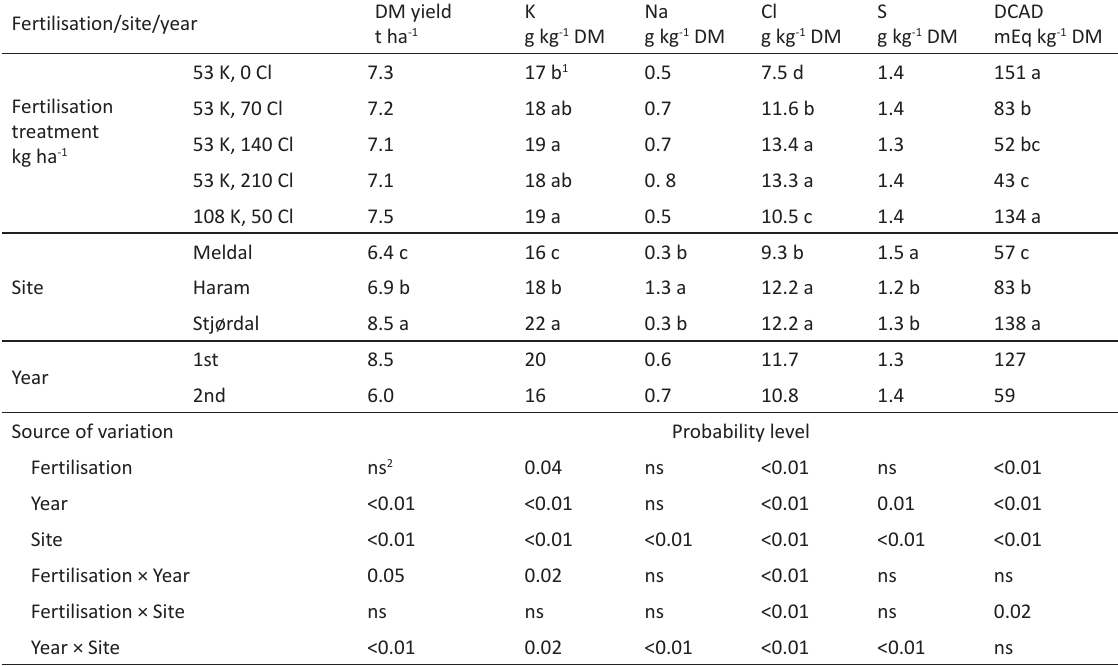
Table 2. Experiment 1: Forage dry matter yield, concentrations of mineral dietary cation-anion difference (DCAD) at the first cut of fields dominated by timothy and meadow fescue, fertilised with different amounts of chloride and potassium, and harvested at three locations (Meldal, Stjørdal and Haram) during two